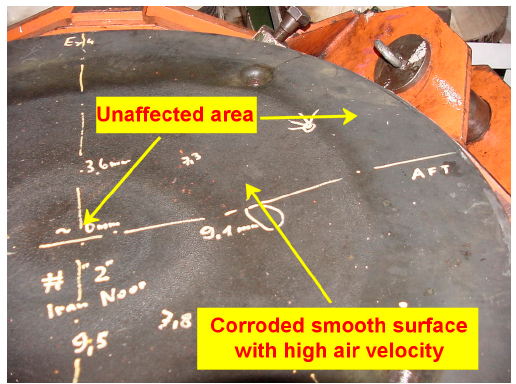
Figure 2. Unaffected area on the crown.